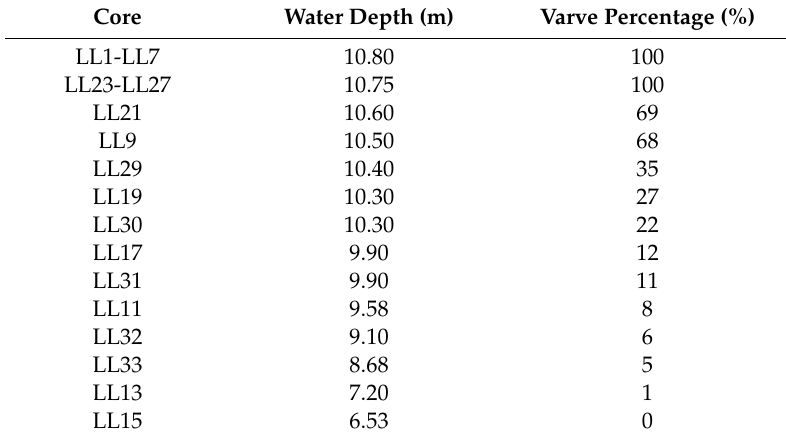
Table 2. Percentages of varved sediments for freeze cores from di ff erent water depths.